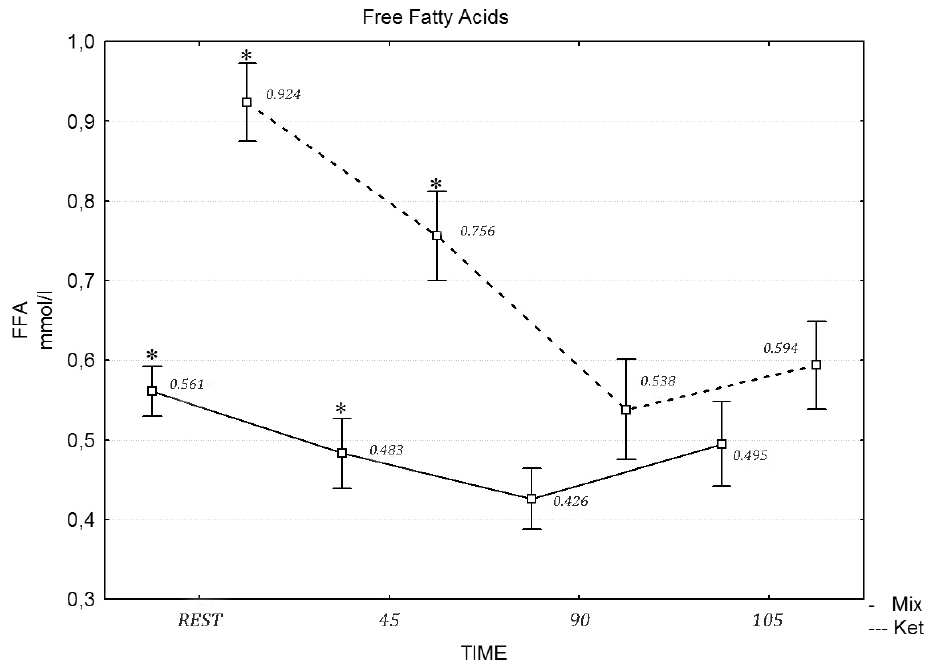
Figure 1. The concentration of free fatty acids (FFA) during the exercise protocol, after a mixed and ketogenic diet. * Statistical significance with p <